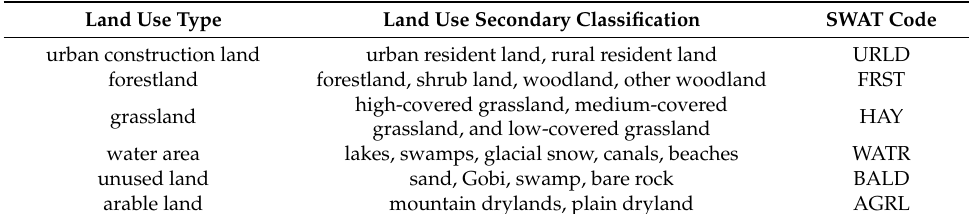
Table 1. Land use/cover type.